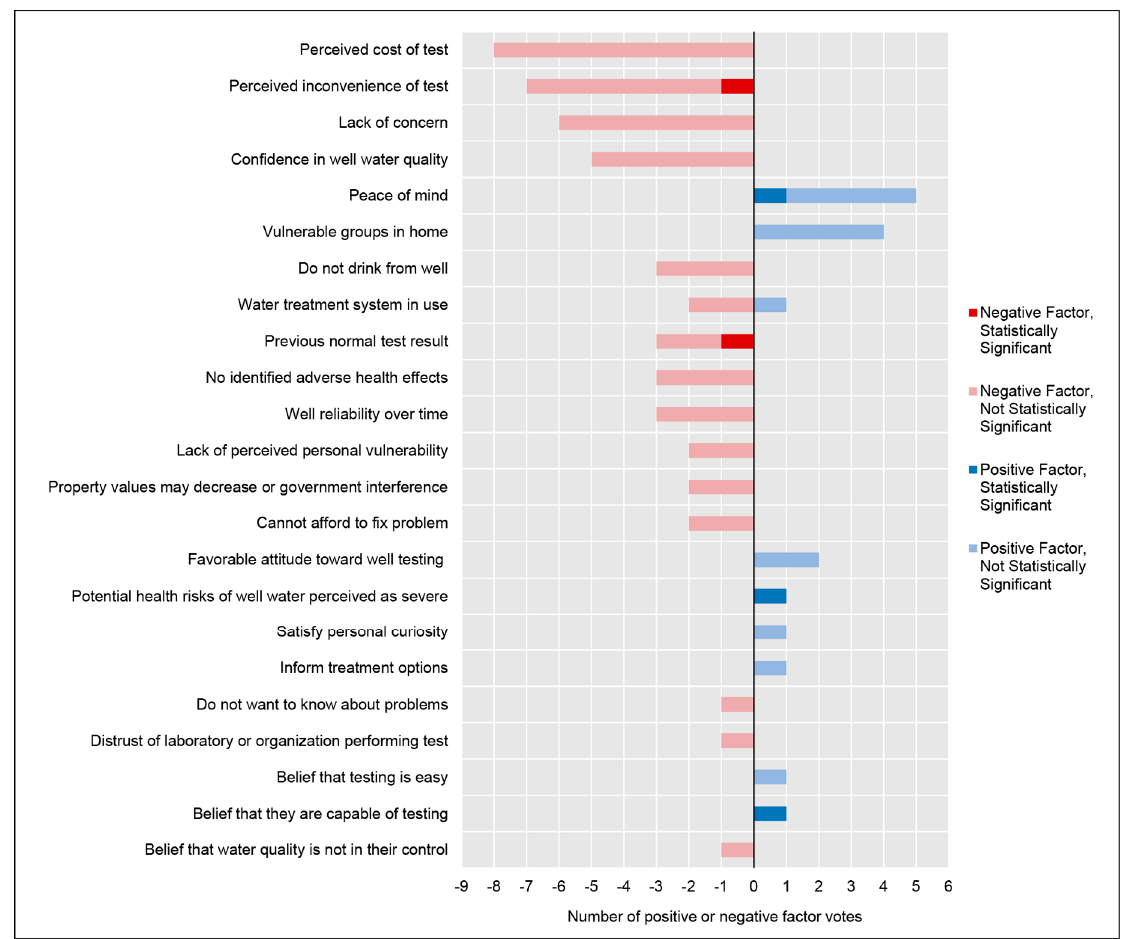
Figure 4. Counts and associations of individual beliefs identified in the literature. Individual